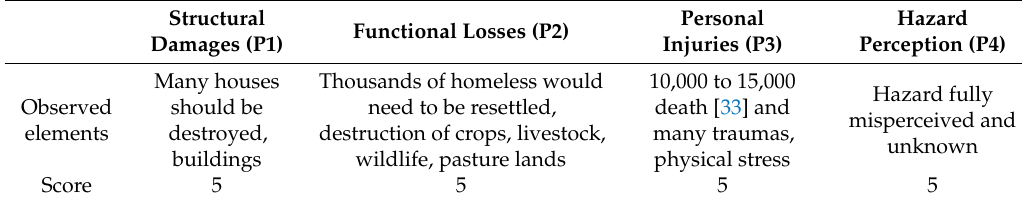
Figure 14. Katsina and Menchum rivers longitudinal profiles. Two main features are recognizable: Table 5. Severity assessment of the lake Nyos flood hazard. highland areas > 2000 m a.s.l. located within large volcanic units; and low altitude areas < 1200 m a.s.l. with crystalline bedrock compartmentalized by faults [20]. Table 5. Severity assessment of the lake Nyos flood